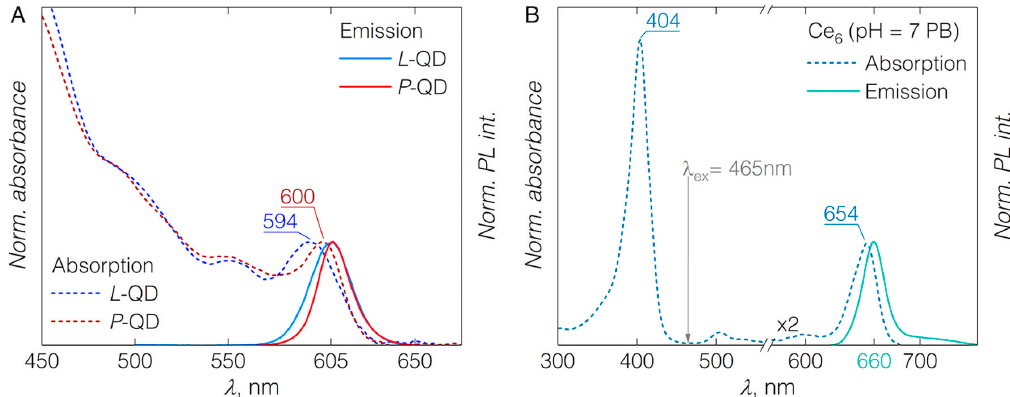
Figure 1. ( A ) Normalized absorption and emission spectra of quantum dots (QDs) functionalized with either phospholipids ( L -QD) or amphiphilic polymer ( P -QD) and bearing amine surface charge. ( B ) Normalized absorption and emission spectra of pure chlorin e 6 (Ce 6 ) in phosphate buffer (PB) (pH 7); note, the absorption region of Q(I) band is magnified for clarity; labels indicate absorption maxima position in nanometers. Emission spectra were measured with 400 nm excitation light. Arrow indicates excitation wavelength of 465 nm, used for Förster resonance energy transfer (FRET) studies.